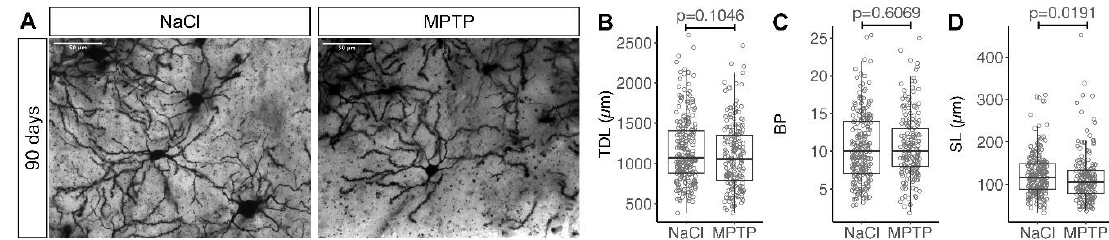
Figure 4. Recovery of dendritic arborization 90 days after MPTP. ( A ) Representative images of Golgi stained MSN in the striatum analyzed 90 days after the last MPTP injection. Scale bars 50 µ m. ( B ) Total dendritic length (TDL), ( C ) number of branch points (BP) per MSN, ( D ) segment length (SL = TDL / BP). Each marker represents one MSN. Numbers of MSN are in Table 1. p values are from Mann–Whitney tests.